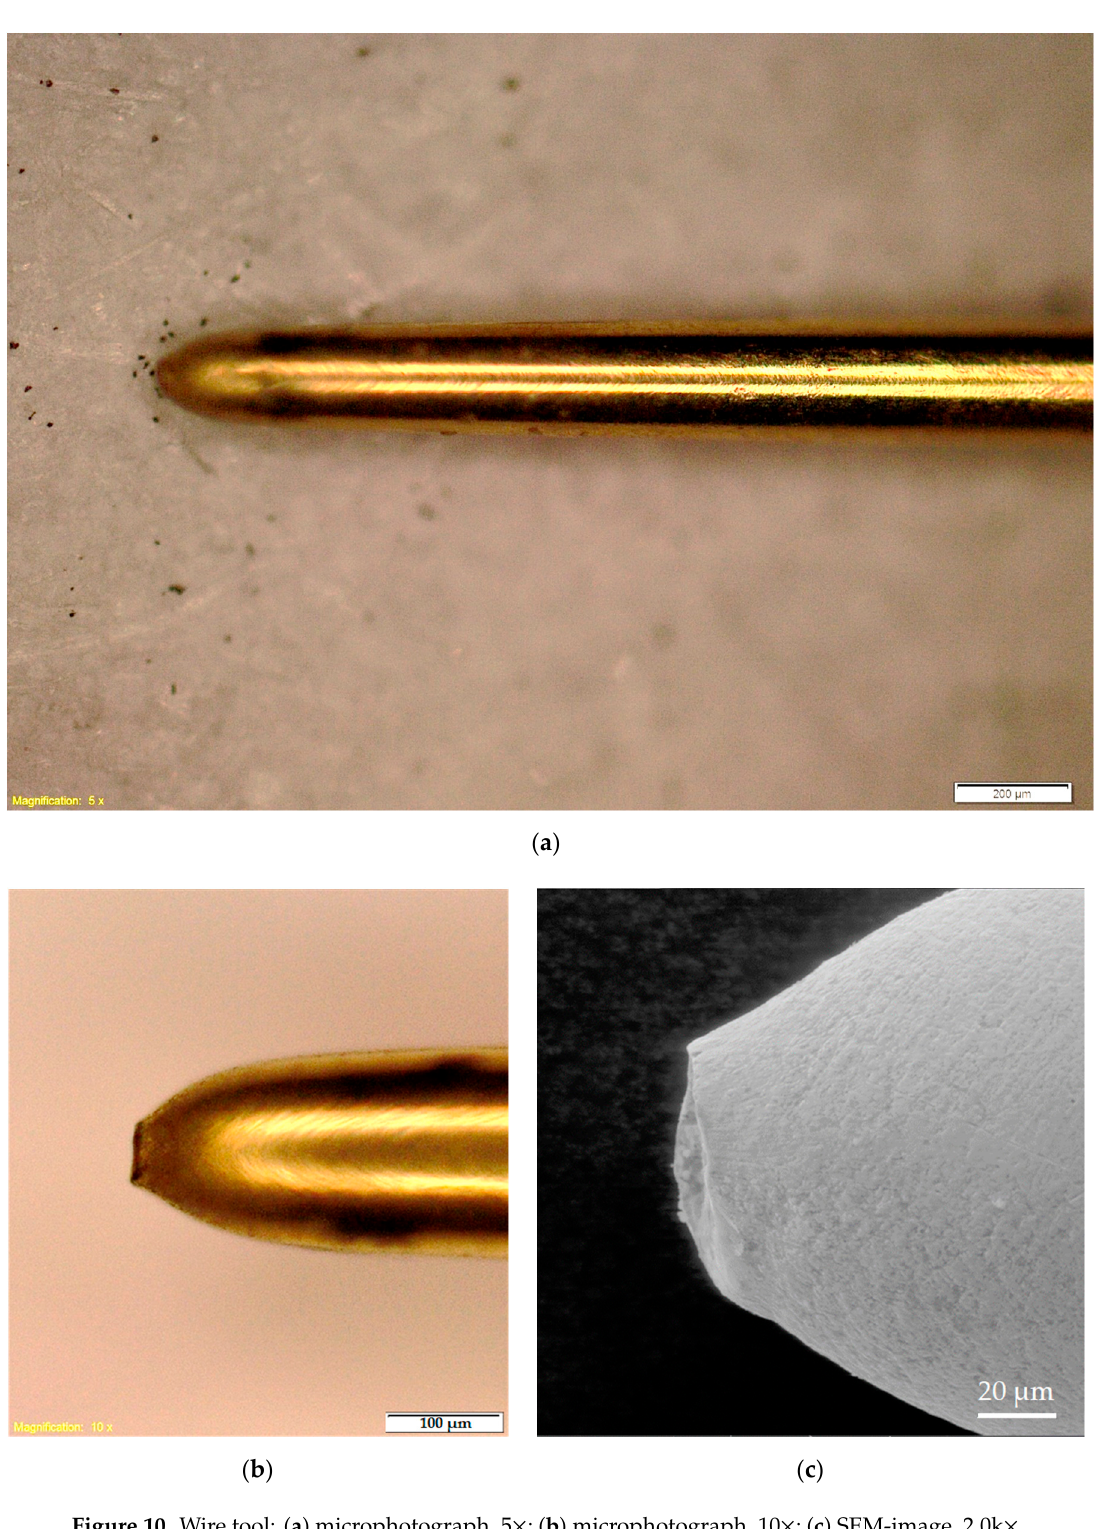
Figure 10. Wire tool: ( a ) microphotograph, 5×; ( b ) microphotograph, 10×; ( c ) SEM-image, 2.0k×.